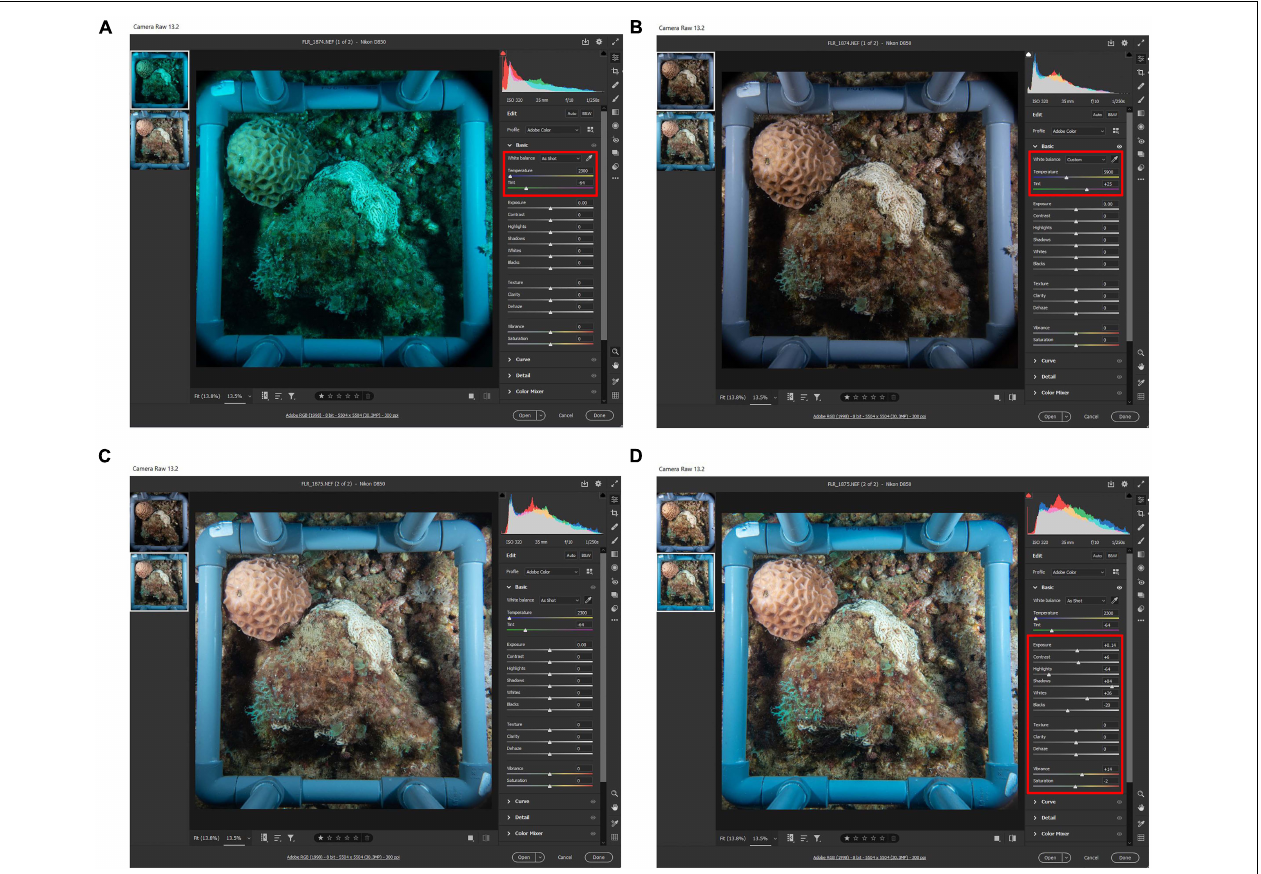
FIGURE 3 | Demonstrating the irrelevance of the Infrared Cut Filter. (A) Raw image taken with ICF on the camera port. (B) The same image from A after white balance (WB) correction in post processing using adobe camera raw (Adobe, United States). (C) Raw image taken without ICF shows the correct colors without the need of WB correction. (D) The same image from C after automatic editing tool using adobe camera raw (Adobe, United States). Red box indicates the command